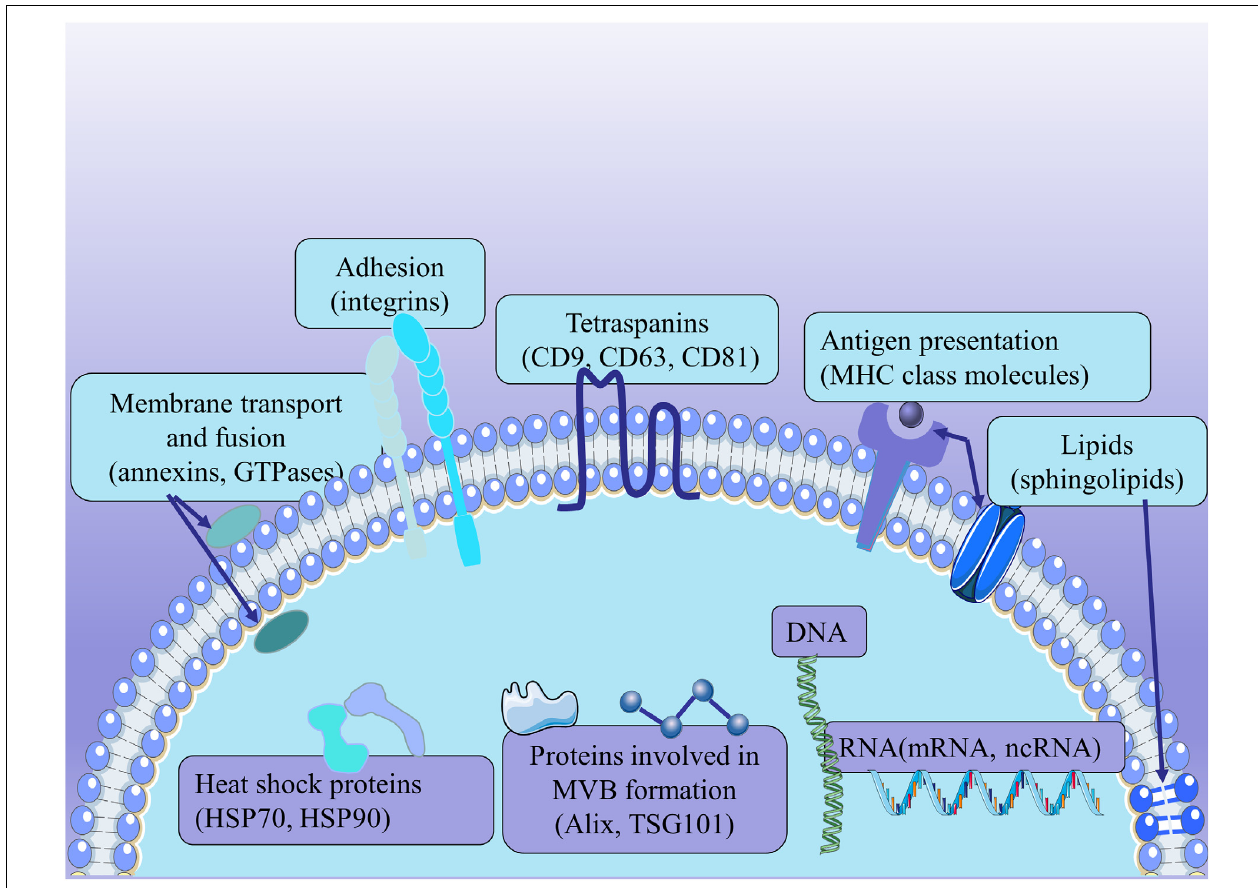
FIGURE 2 | The structure of exosomes. Exosomes express the proteins involved in MVB formation (Alix and TSG101), membrane transport and fusion (annexins, GTPases), adhesion (integrins), tetraspanins (CD9, CD63, CD81), antigen presentation [major histocompatibility complex (MHC) class molecules], and heat shock proteins (HSP70, HSP90). Exosomes derived from MSCs carry a complex cargo, including nucleic acids, proteins, lipids, and